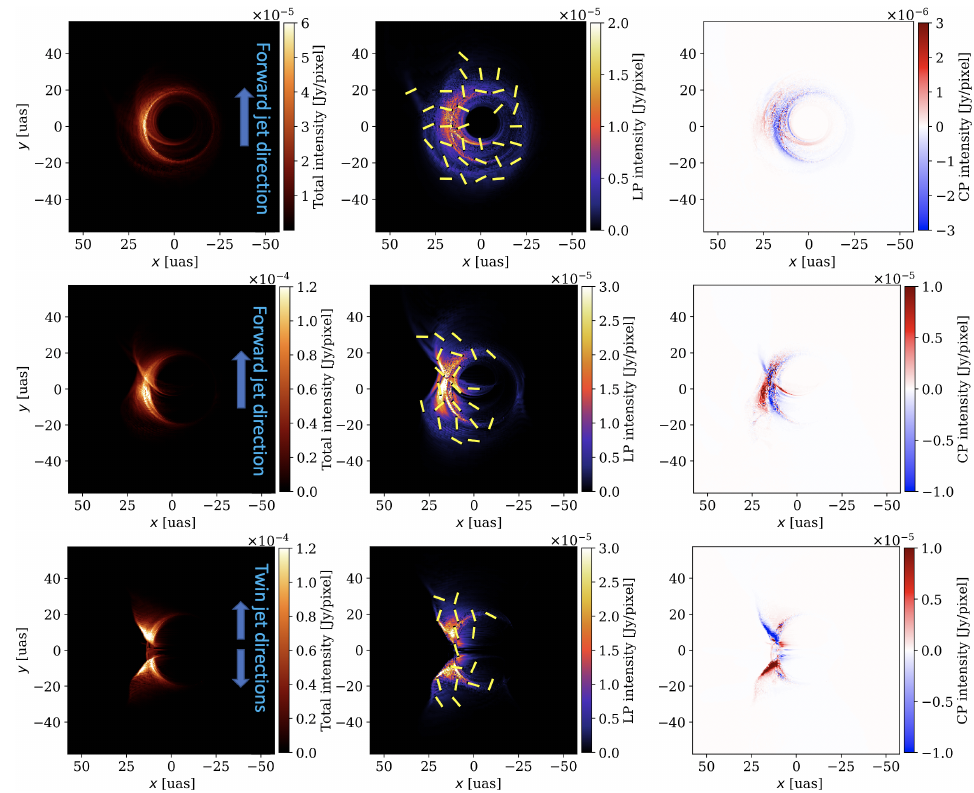
Figure 2. A calculated polarization images at 230 GHz for three viewing angles of i = 20 ◦ (nearly face-on), 50 ◦ (intermediate), and 90 ◦ (edge-on), top to bottom. ( Left ) Total intensity (Stokes I ) image. Each image consists of 600 × 600 pixels. The forward jet extends upward on the image. ( Center ) LP map. The LP intensity is shown by the color contour, with LP vectors in electric vector position angle (EVPA) overwritten. ( Right ) CP image. The CP intensity (Stokes V ) is shown by the color contour with sign. A movie of all the images for i = 0–180 ◦ can be found on https://youtu.be/065qAx6Tff0 (accessed on 16 October